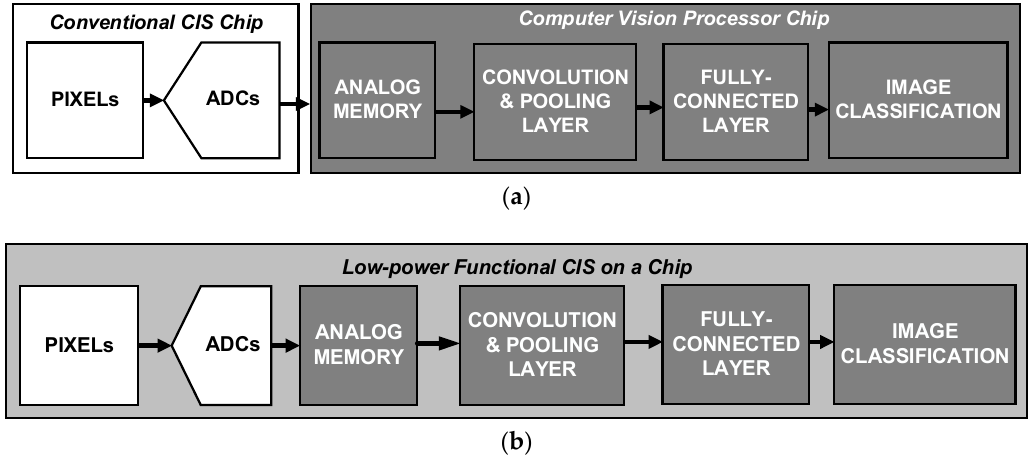
Figure 1. ( a ) Conventional image classification pipeline using a vision processor (two-chip system), and ( b ) the low-power face detection/recognition system in a